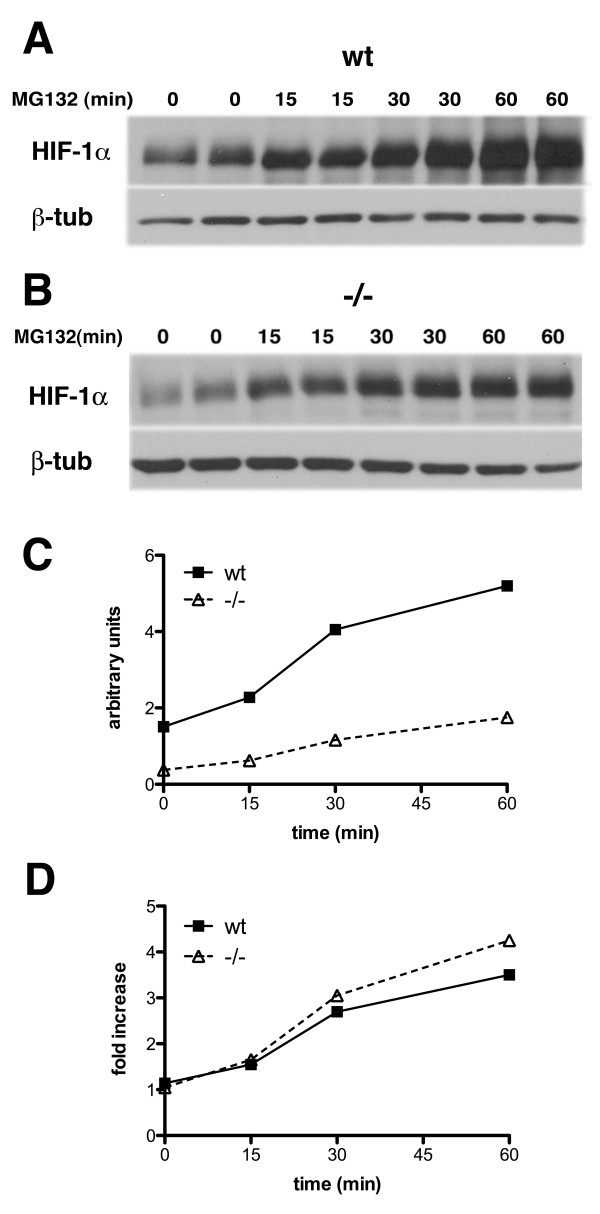
Synthesis rates of HIF-1α are unchanged in Psen1-/- fibroblasts. Psen1+/+ (A) and Psen1-/- (B) fibroblasts were treated with the proteasome inhibitor MG132 for the indicated times (min). Lysates were prepared and Western blotting was performed using an anti-HIF-1α antibody. The lower panels show the blots reprobed for β-tubulin. In panels C and D, the rate of accumulation of HIF-1α normalized to β-tubulin levels from the experiments in panels A and B is shown either as the raw data (C) or normalized to basal levels of HIF-1α in the respective cell types (D). Note that although basal levels of HIF-1α are lower in Psen1-/- fibroblasts, HIF-1α accumulated at similar rates in Psen1+/+ and Psen1-/- fibroblasts. A representative example is shown from experiments that were performed multiple times.